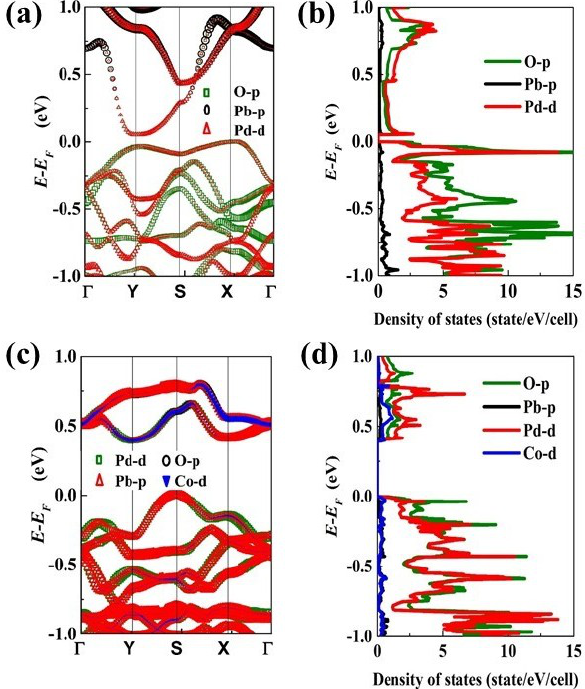
Figure 2. ( a ) electronic structures, and ( b ) orbital-resolved partial density of states (DOS) of (002) orientation PbPdO 2 slab; ( c ) electronic structures, and ( d ) orbital-resolved partial DOS of (211) orientation PbPd 0.75 Co 0.25 O 2 slab. The abscissa in ( a , c ) is the path of high symmetry points in Brillouin zone.